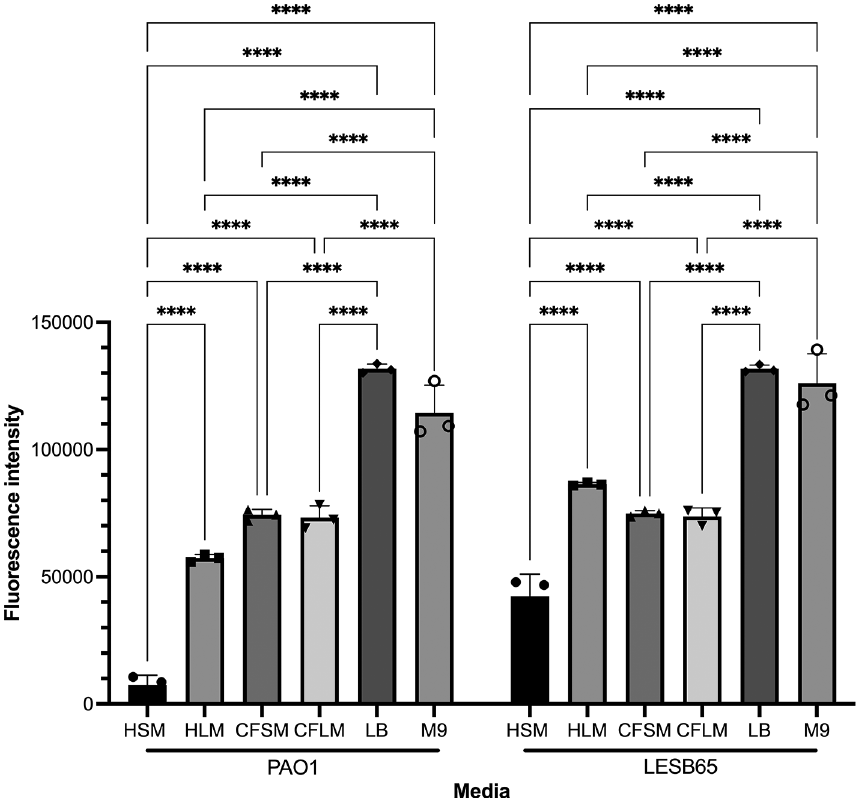
Figure 3. Free-floating biofilm formation in respiratory-mimicking media in comparison to two common laboratory media. Bacteria were left to form biofilms for 72 hours and biofilms were disrupted with cellulase. Cultures were incubated with resazurin dye for 2 hrs. Released fluorescence was measured at 540 nm excitation λ and 590 nm emission λ . Background fluorescence of each media is corrected by subtraction of the background fluorescenceobtainedfromthewellswithmediaonly.StatisticalanalysiswasundertakenusingGraphpadPrism8.0. Statistical analysis: Two-way ANOVA *p < 0.05, **p < 0.01, ***p < 0.001, ****p < 0.0001. Each bar graph represents 3 biological replicates (mean), each with 30 technical replicates, n:90, error bars show standard